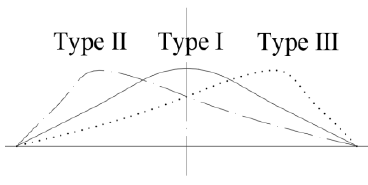
Figure 6. Bubble